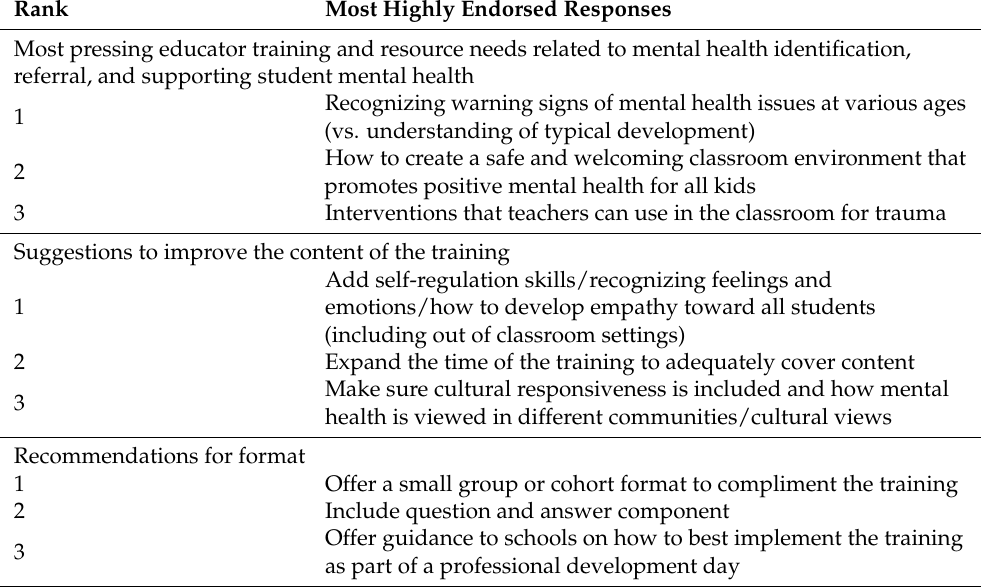
Table 2. Focus group